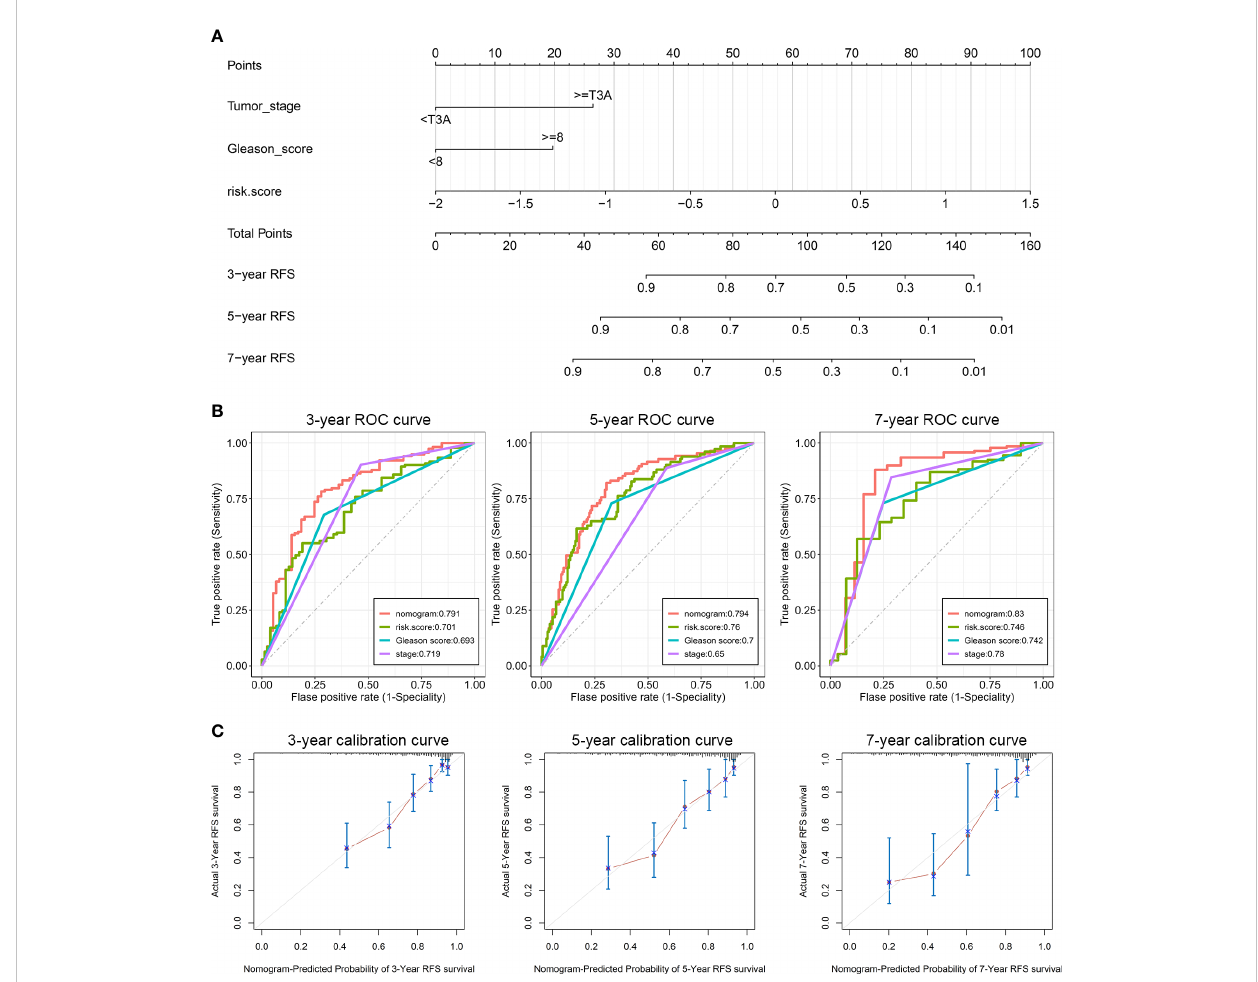
8.33e-10), G2M checkpoint (NES = 1.77, FDR = 2.80e-06), and mitotic spindle (NES = 1.39, FDR = 0.014), were signi fi cantly enriched in the high-risk group. The correlation analysis revealed the signi fi cantly positive relation between ENZ-sig and cell cycle score in PCa [correlation coef fi cient (corr) = 0.256, p = 7.62e-09; Figure 6H], indicating that ENZ-sig mediated the activation of cell cycle pathway that contributed to increasing risk of progression and poor outcome for PCa. Moreover, cell cycle – related genes,